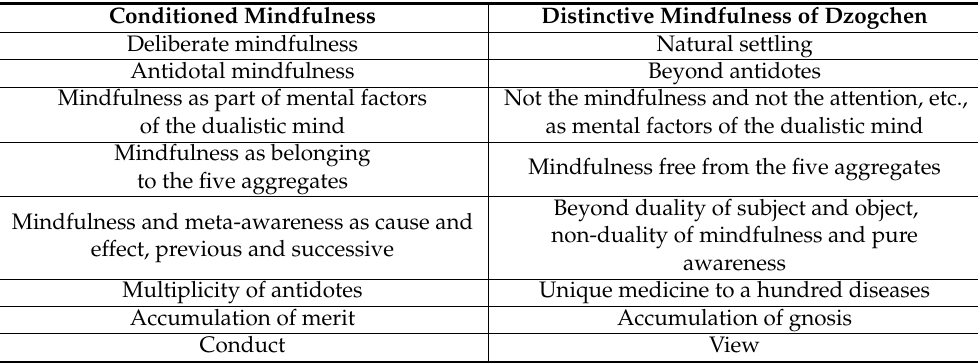
Table 2. Two styles of mindfulness according to Jigme